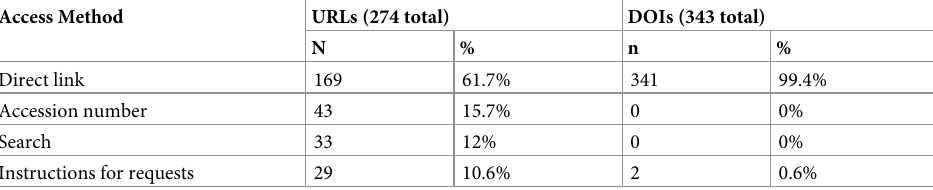
Table 3. Method of access for resources by identifier type for manually retrieved